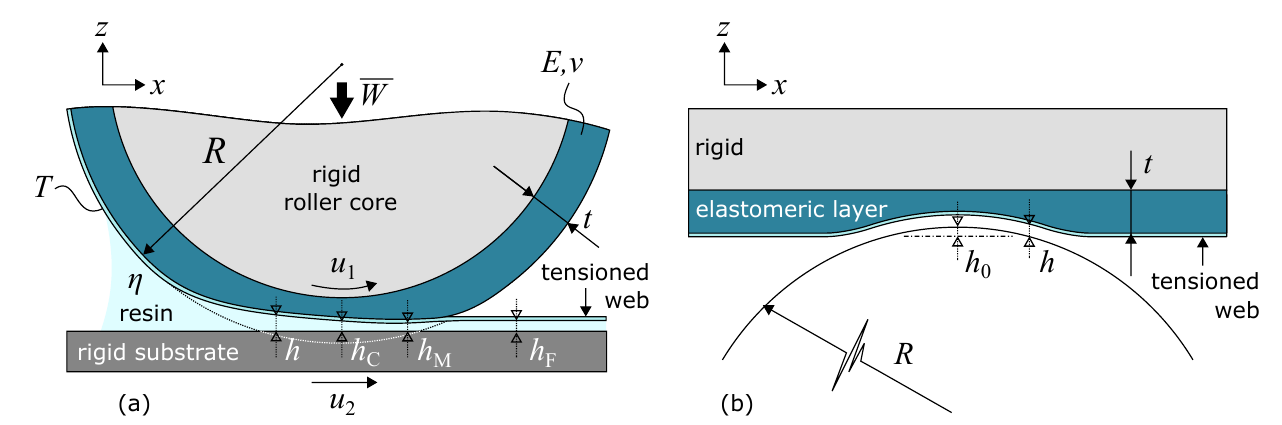
Figure 2. ( a ) Schematic of the imprint roller with tensioned web. The elastic deformation of the elastomeric layer is highly exaggerated for illustrative purposes. ( b ) Equivalent geometry of the imprint roller with tensioned web.